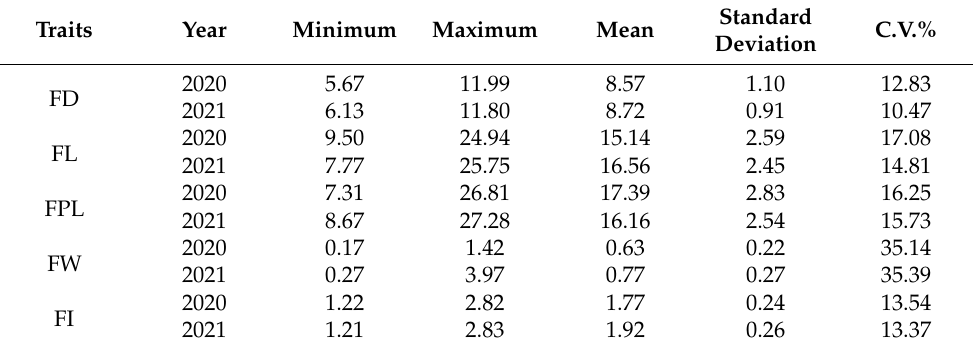
Table 3. Representative values of the main fruit traits in F 1 hybrids from four